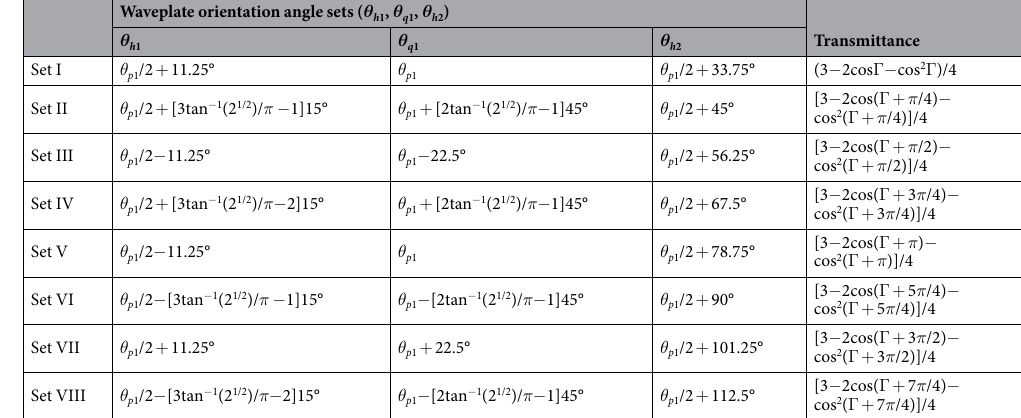
Table 1. Eight selected sets of waveplate angles for wavelength tuning and corresponding filter transmittances with flat-top